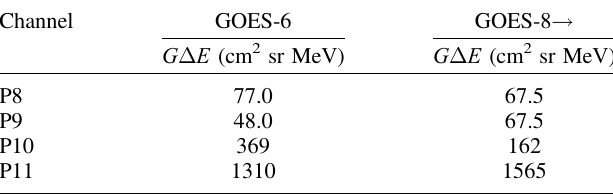
Table A.3. Nominal G (cid:2) E values used in GOES data processing.